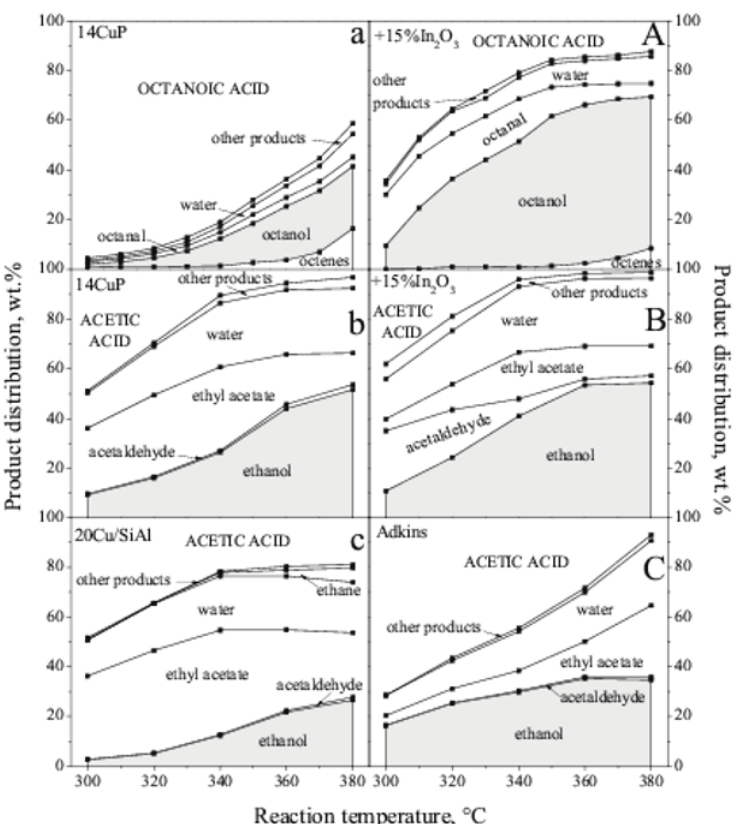
Figure 3. Product distribution of 14CuP (a,A) converted OA, 14CuP (b,B), 20Cu/SiAl (c) and conventional Adkins catalysts (C) converted acetic acid under conditions applied in Fig. 2. Fig. 3A and B show the effects of 15 wt.% In